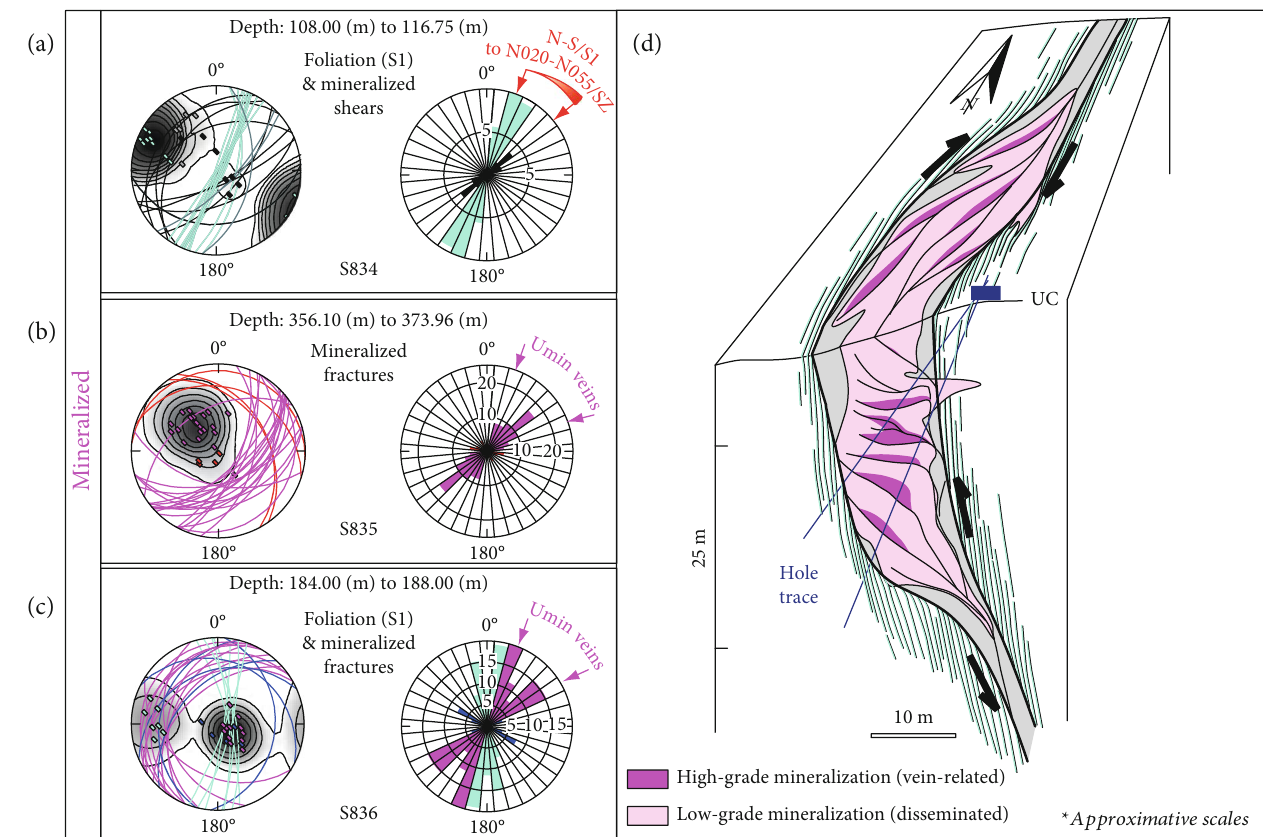
Figure 8: (a, b, and c) ATV oriented data analysis from the mineralized intervals in drill holes S834, S835, and S836, respectively, showing the arrangement of foliation and mineralized shears and fractures/veins. (d) Schematic drawing of the structural interpretation for mineralized intervals. Explanation in the